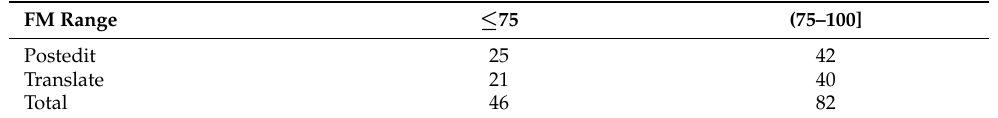
Table 10. Number of Sentences by Range.